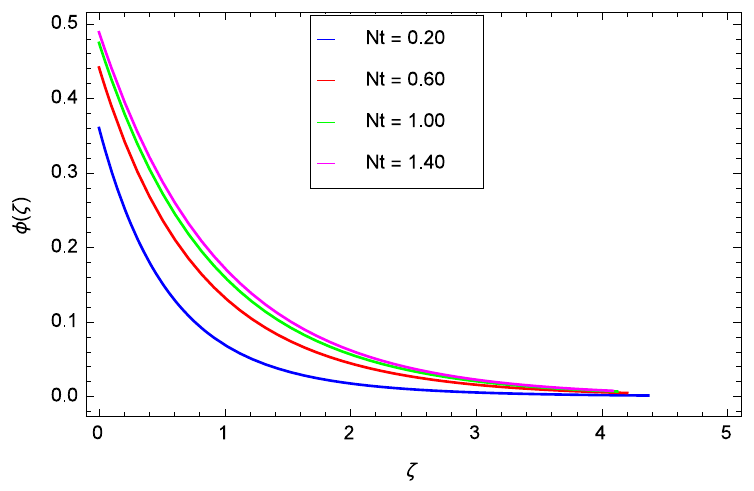
Figure 19. Influence of Nt on φ ( ζ ) .